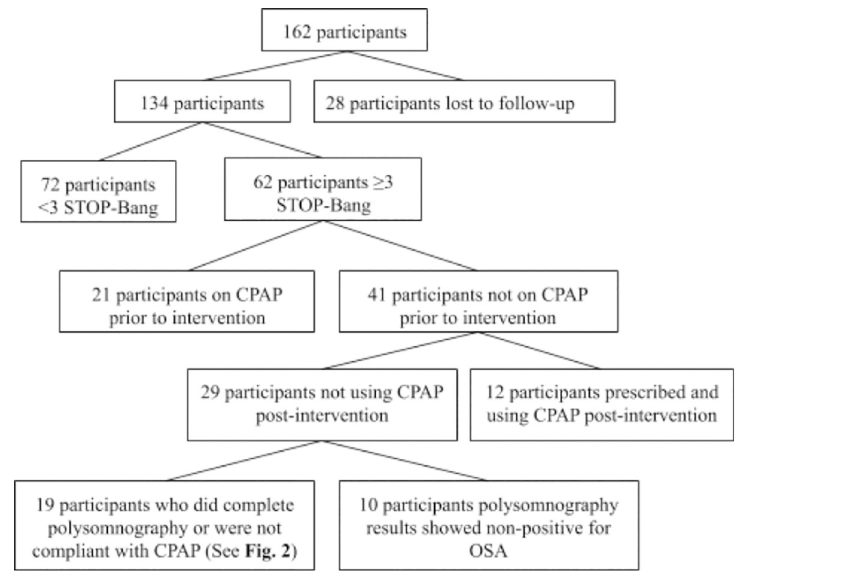
Fig 1. Participant